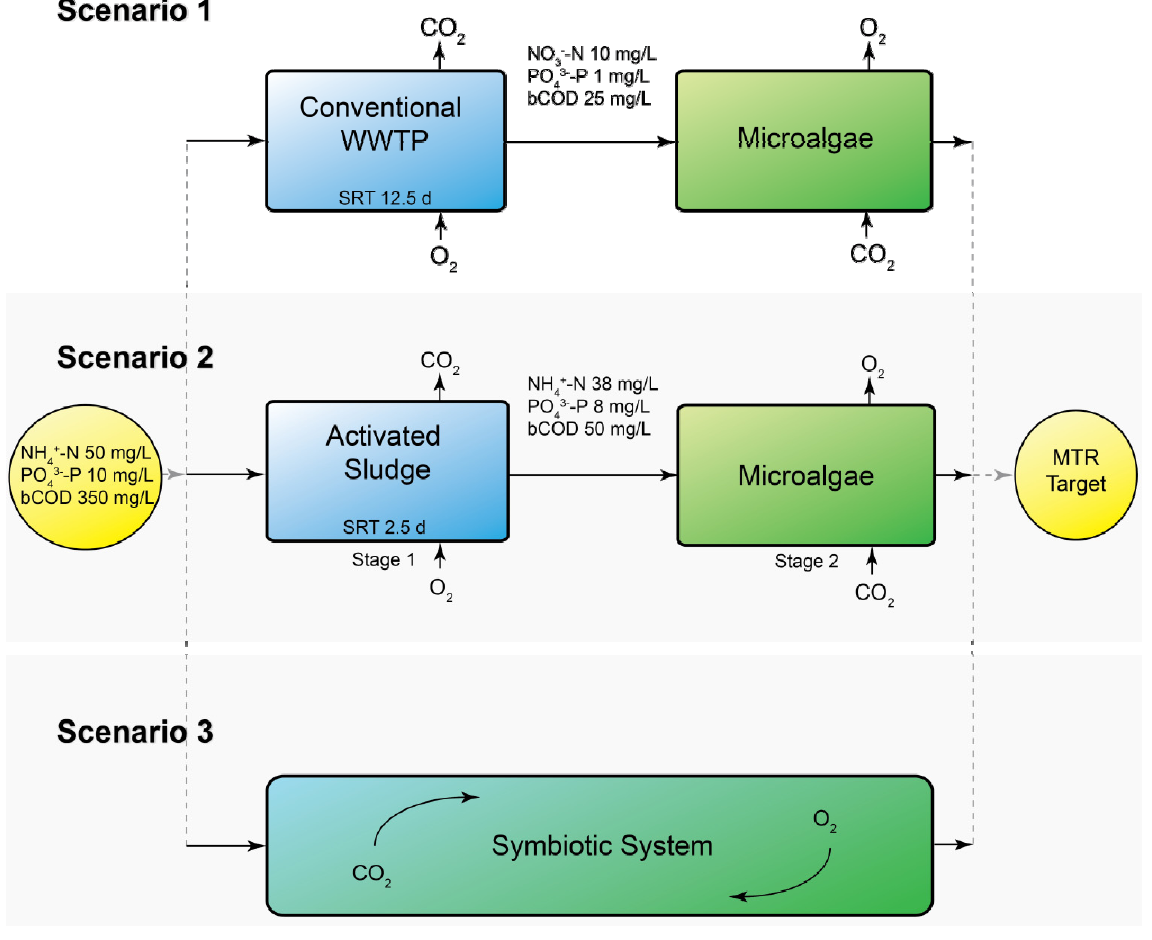
Figure 1. Schematic overview of the three different scenarios of using microalgal biofilms in municipal wastewater treatment. The incoming wastewater and target effluent MTR values of 2.2 mg/L N and 0.15 mg/L P are equal for all scenarios. The sludge retention time (SRT) is shown for the activated sludge compartments of Scenarios 1 and